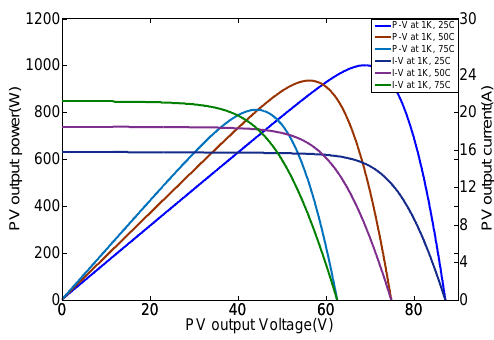
Figure 3. PV cell characteristics curves under different temperatures.